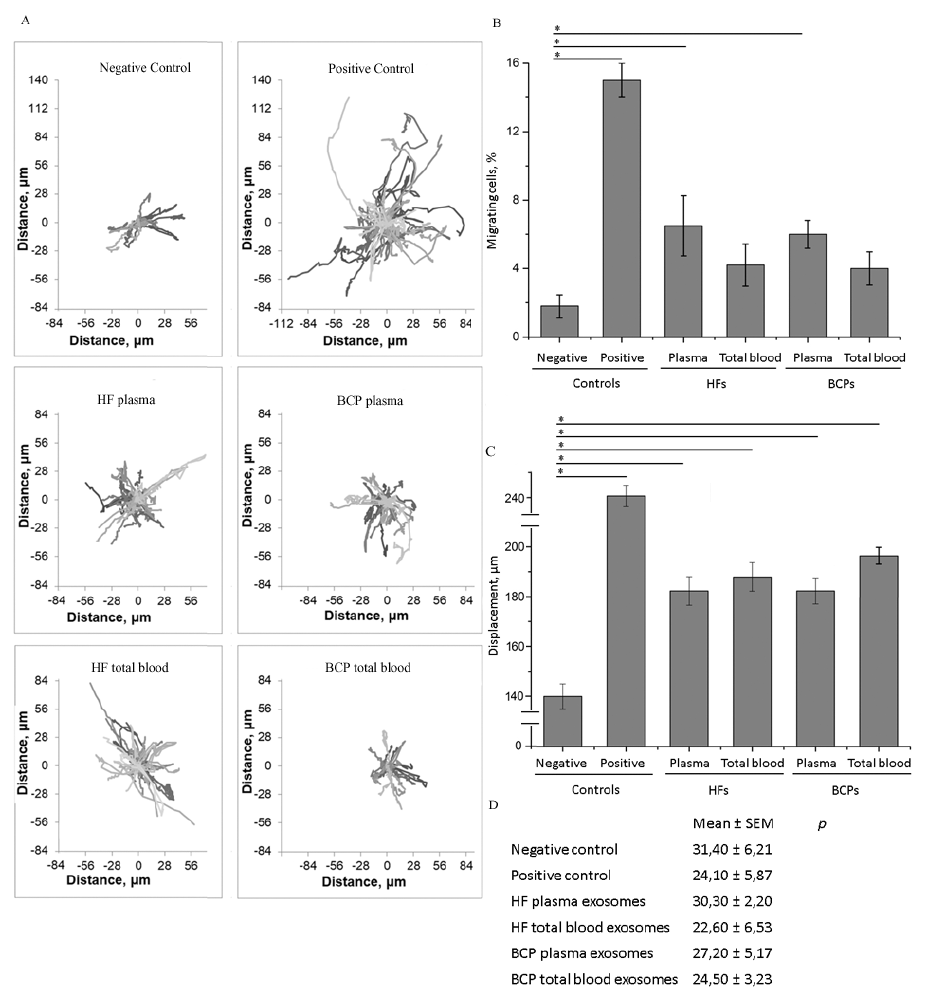
Figure 5. The effects of plasma and total blood exosomes on SKBR3 cell migration and proliferation. Results of three independent experiments are presented as mean ± SEM, * p < 0.05 vs. negative control. Trajectory plots of single-cell migration experiments on SKBR3 in the presence or absence of exosomes ( A ), the proportion of motile cells ( B ), displacement over 15 h ( C ), and mitotic activity (percentage of mitosis events during 15 h of observation) ( D ).